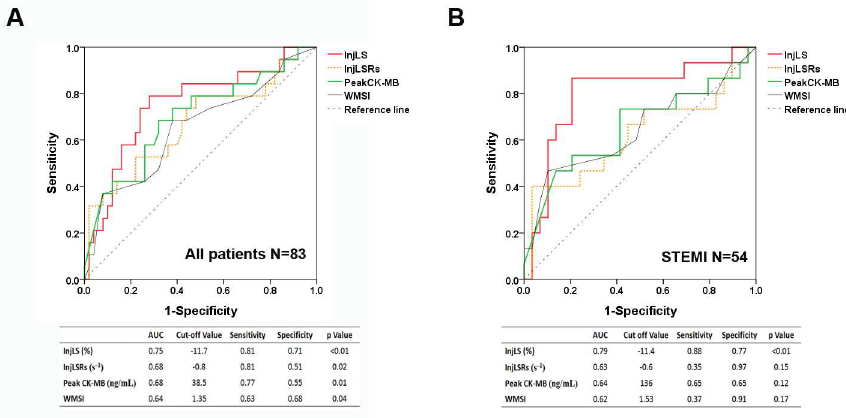
Fig 2. Receiver operatingcurve analysisfor the prediction of left ventricular remodeling6 months after acute myocardialinfarction (A) for all population(B) for a subgroupof ST-segment elevationmyocardialinfarction